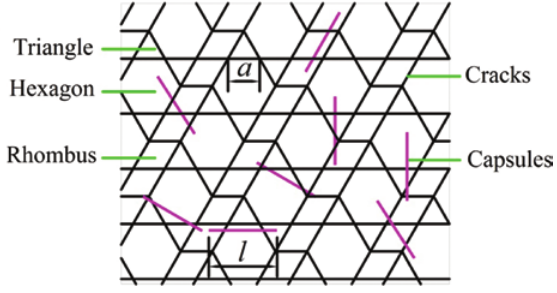
Figure 2: A triple-shaped crack distribution composed of triangles, rhombuses, and